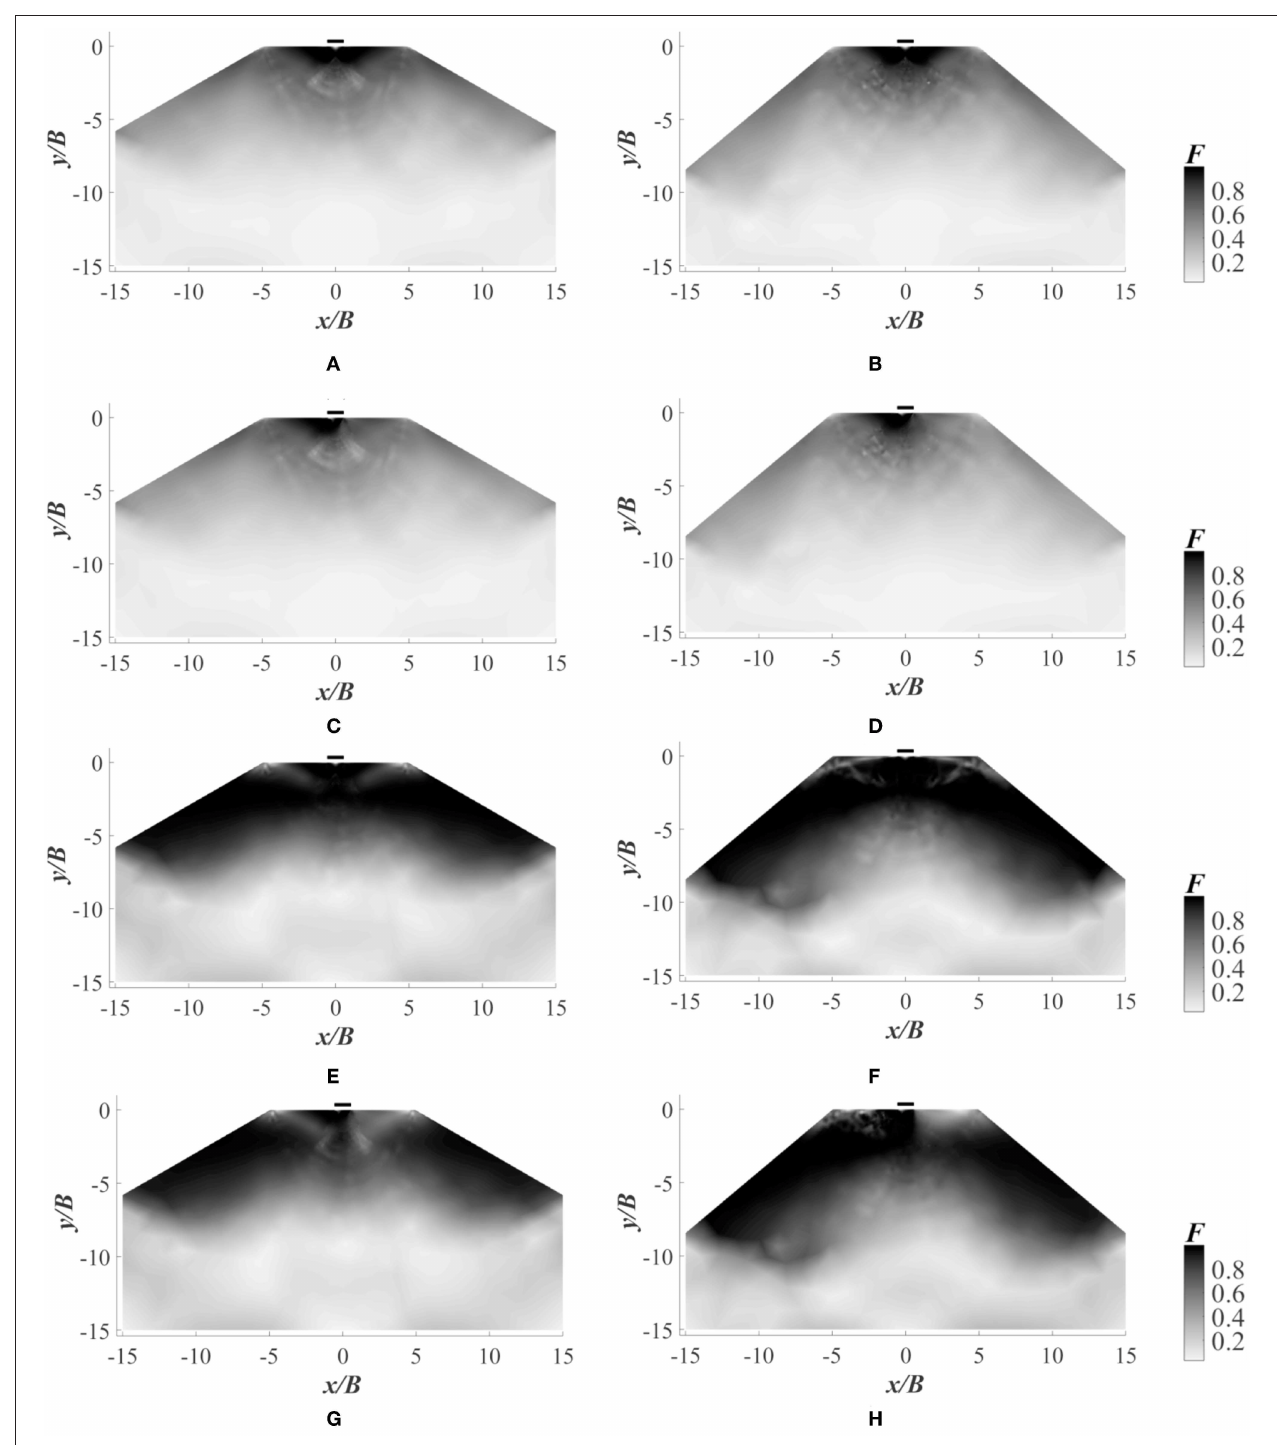
FIGURE 6 | Failure contours for S/B for S/B 4 and b/a 0.8 with (E) β = = from 1.0 to 0.8 for a footing with S/B value becomes higher from 13.75 to 45.43% for the increase in β value from 10 to 40 ◦ , respectively. In the same way when setback